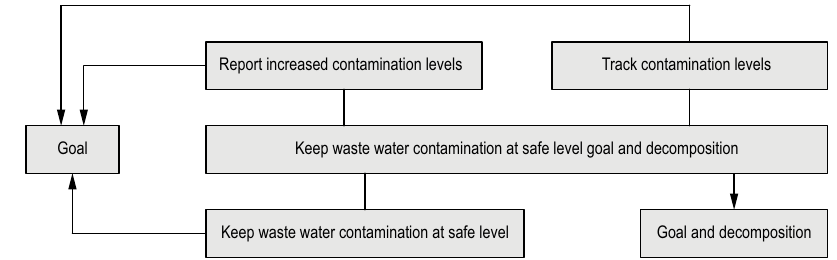
Report increased contamination levels Track contamination levels